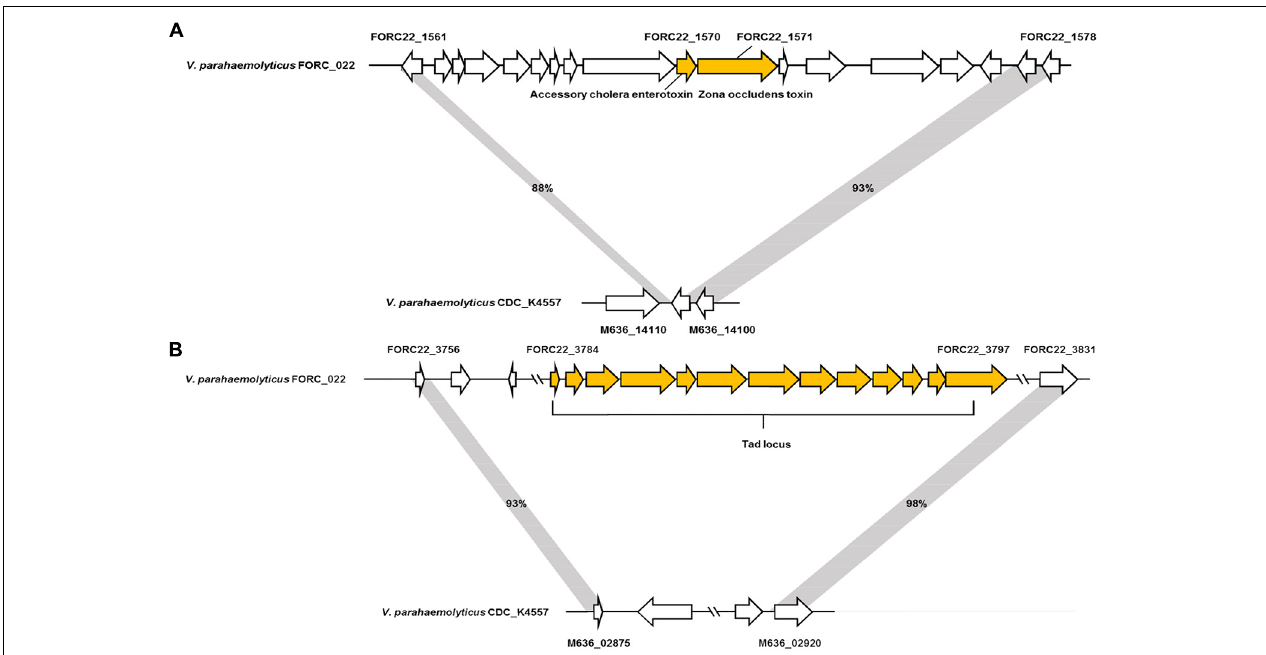
FIGURE 2 | Two non-homologous regions between FORC_022 and CDC_K4557 strains. (A) Different regions detected in chromosome I and (B) chromosome II of FORC_022.